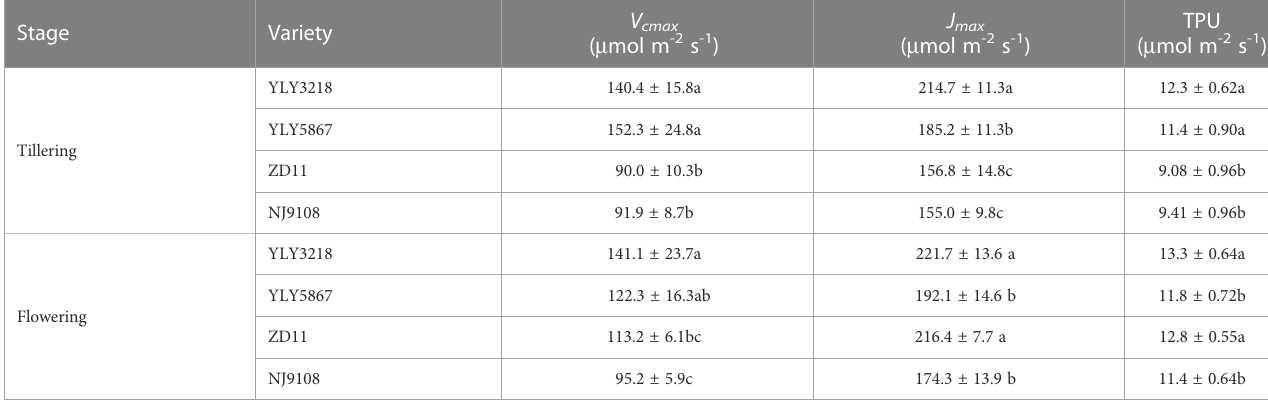
TABLE 2 Maximum carboxylation rate, maximum electron transfer rate and triose phosphate utilization rate of the latest fully expanded leaves for different rice cultivars during tillering and fl owering stage.